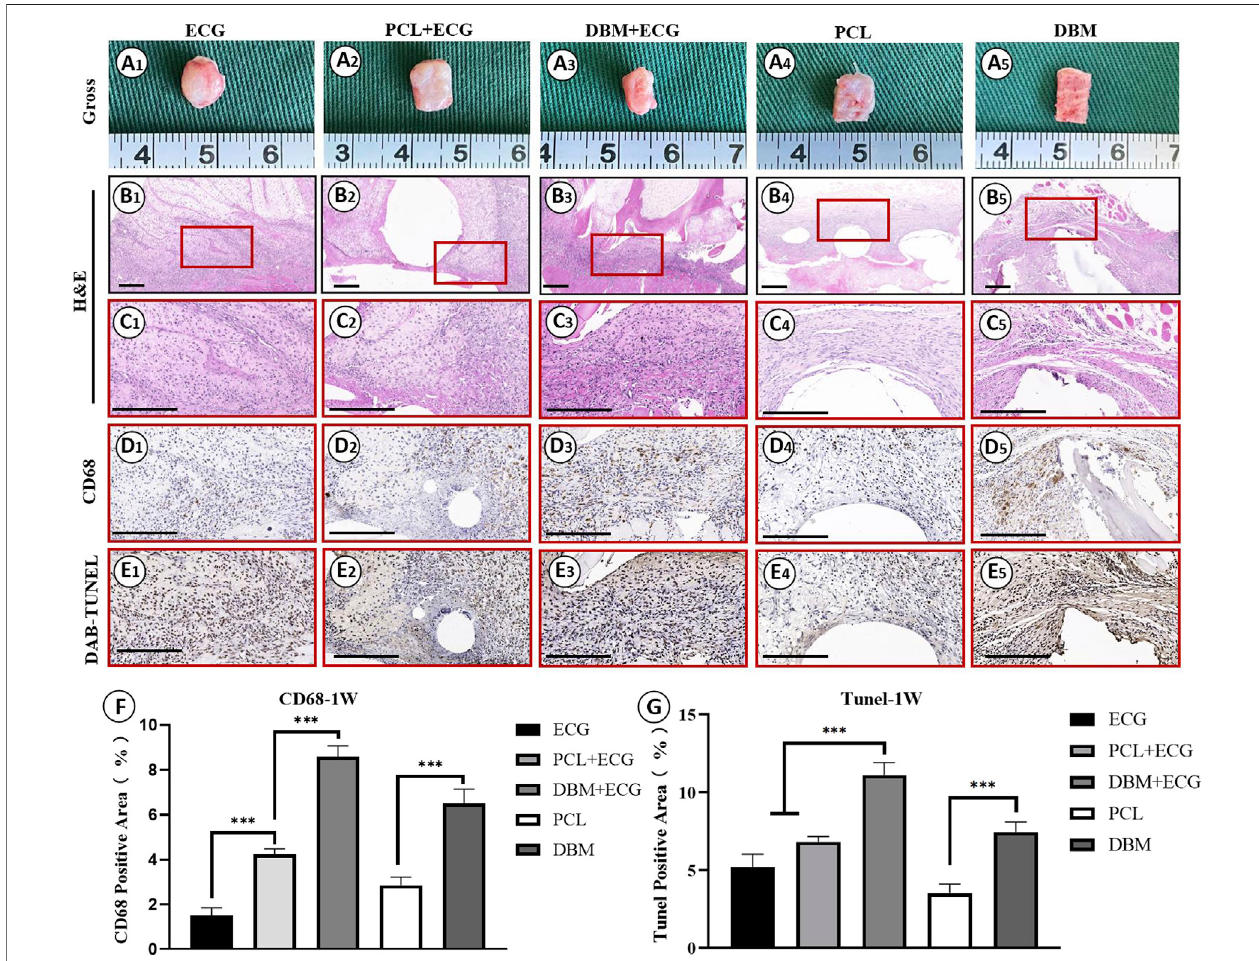
FIGURE 4 | In fl ammatory response evaluations of ECG, frameworks, and framework-ECG constructions after 1 week of subcutaneous implantation: Gross observation (A1 – AA) ; H&E staining with different magni fi cation (B1 – B5, C1 – C5) ; CD68 immunohistochemical staining (D1 – D5) ; DAB-TUNEL immunohistochemical staining (E1 – E5) ; Semi-quantitative analysis of the CD68 (F) and DAB-TUNEL (G) positive area (%). Statistical signi fi cance: p p < 0.05, pp p < 0.01, ppp p < 0.001. Scale bar: 200 μ